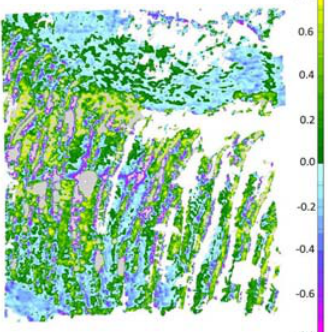
Figure 5 – Error map: DM, Template 25,